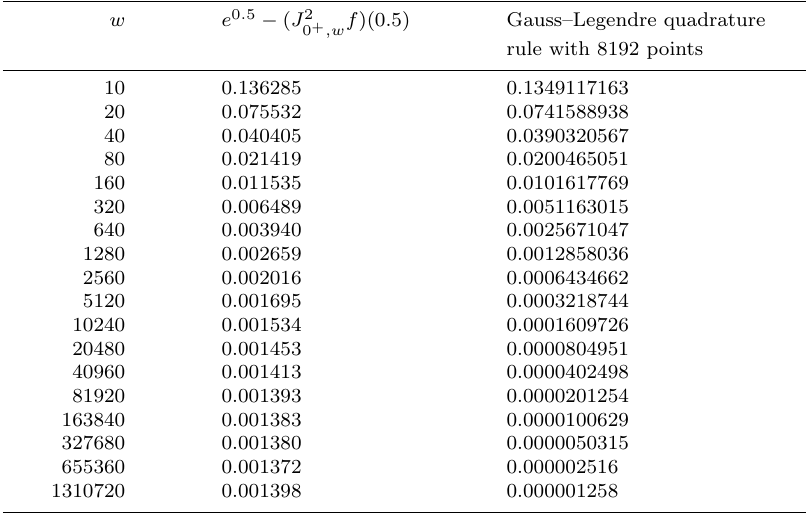
Table 1. Hadamard integrals values for f = e x on s = 0 . 5. w e 0 . 5 − ( J 2 f )(0 . 0 + ,w